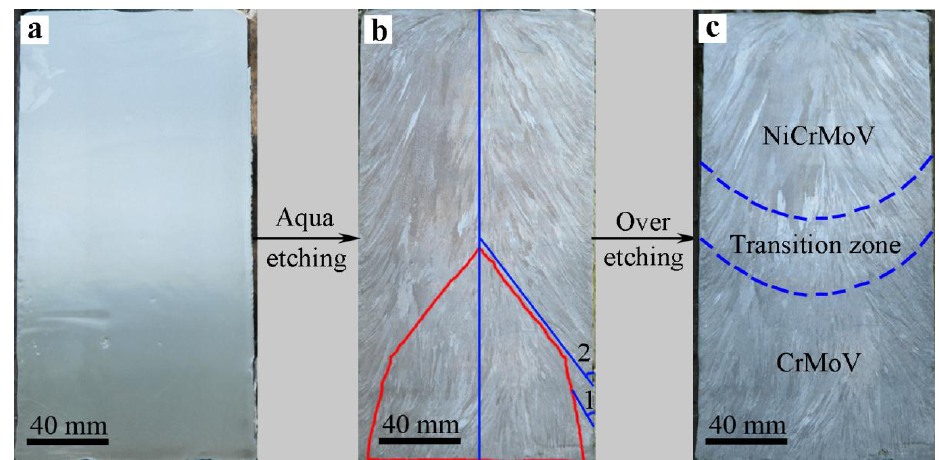
Figure 1. Schematic drawing of the dissection of the electroslag remelting (ESR) ingot.